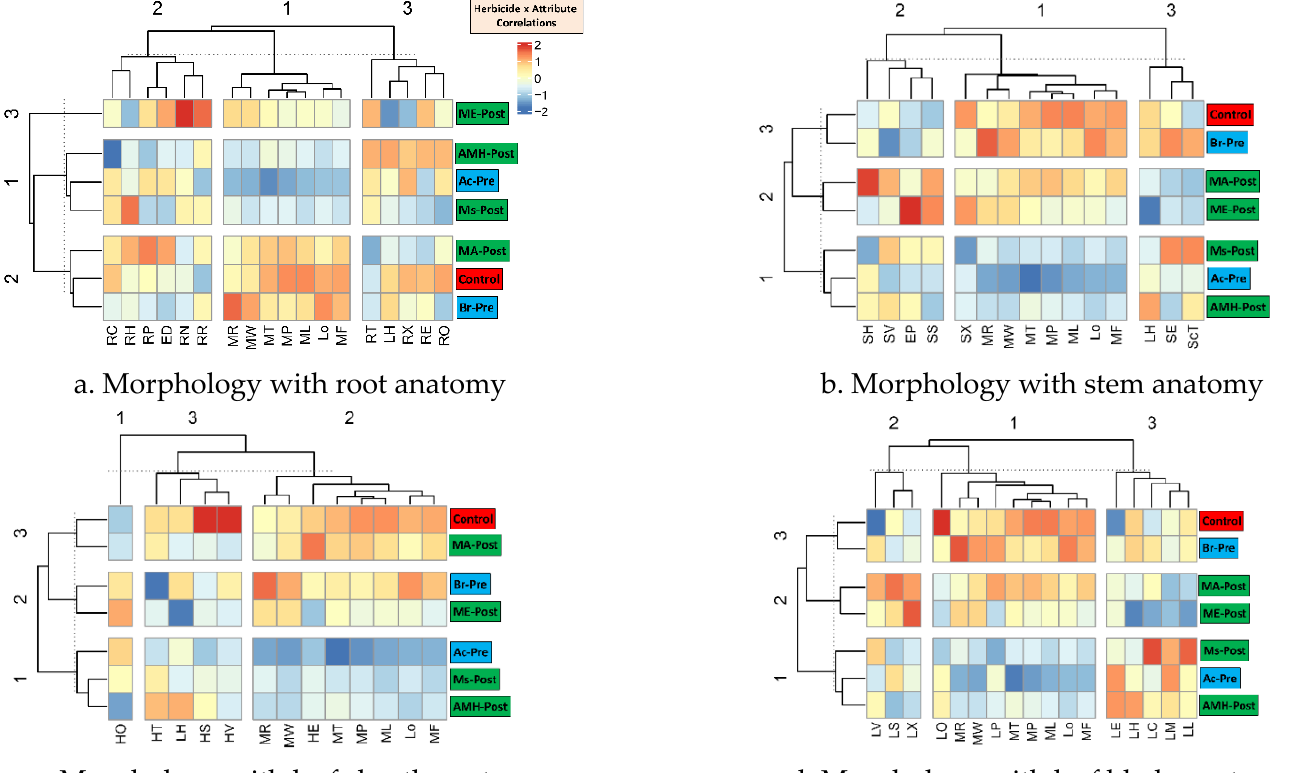
Figure 7. Clustered heatmaps of morphology with root ( a ), stem ( b ), leaf sheath ( c ) and leaf blade ( d ) anatomy of Dactyloctenium aegyptium treated with pre- and post-emergence herbicides. Red color indicates control group, blue show pre-emergence and green is used for post-emergence herbicides. For abbreviations please see list at the end of manuscript.